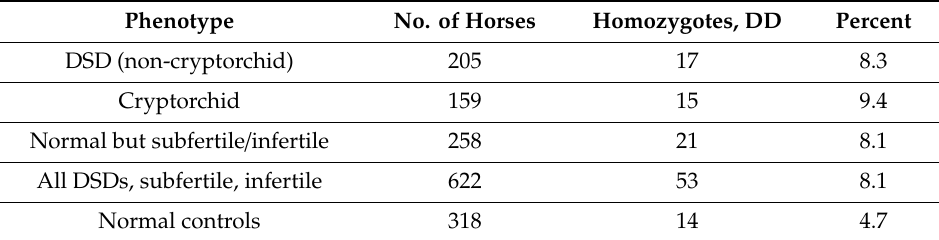
Table 3. Frequency of deletion homozygotes among horses with DSDs and / or fertility problems.